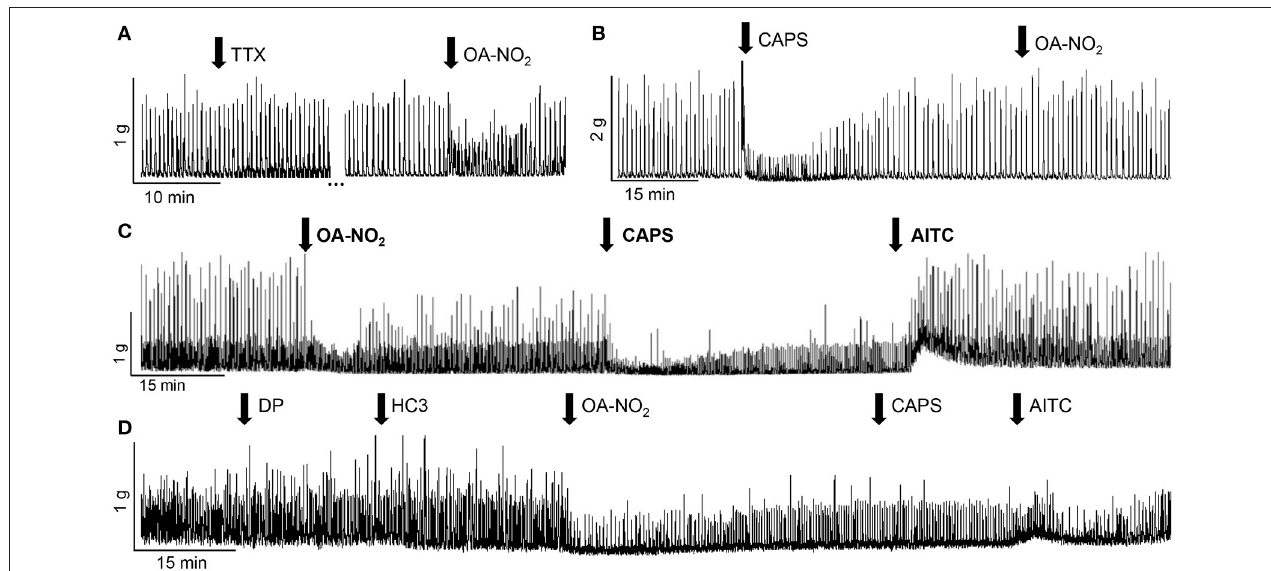
FIGURE 2 | Effects of various agents on SBCs in guinea pig bladder strips. (A) Tetrodotoxin (TTX, 1 µ M) does not alter SBCs or the inhibitory effect of OA-NO 2 (30 µ M). The gap (…) in recording represents 24min. (B) Pretreatment with CAPS (1 µ M) blocks the inhibition elicited by the subsequent administration of OA-NO 2 (30 µ M) in the same bladder strip. (C) Inhibitory responses of OA-NO 2 (30 µ M) and CAPS (1 µ M), and the excitatory response of AITC (100 µ M) elicited in the same bladder strip by sequential application of the three agents, applied at the arrows and maintained in the tissue bath. (D) A combination of antagonists for TRPV1 (diarylpiperazine, DP, 1 µ M) and TRPA1 (HC3-030031, HC3, 10 µ M) does not alter the inhibitory effect of OA-NO 2 (30 µ M) but suppresses the effects on SBCs of the subsequent administration of CAPS (1 µ M) and AITC (100 µ M) in the same bladder strip. Calibration bars refer to time (min) and tension (gram,